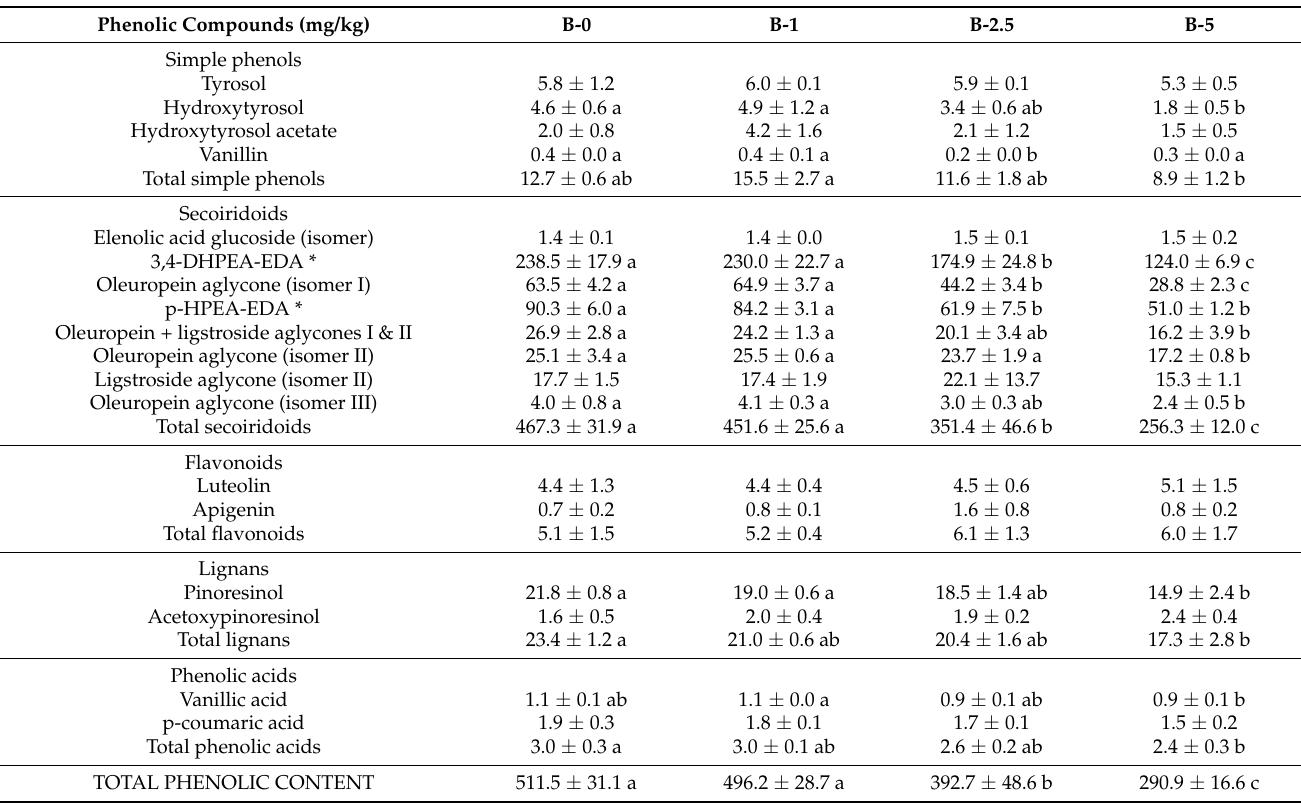
Results represent mean values of three technical repetitions ± standard deviations. Different letters in a row represent significant differences among the treatments (Tukey ´ s test, p < 0.05). * Abbreviations: Decarboxymethyl elenolic acid linked to hydroxytyrosol—3,4-DHPEA-EDA corresponding to isomer II according to the work of Jerman Klen et al. [27]; Decarboxymethyl elenolic acid linked to